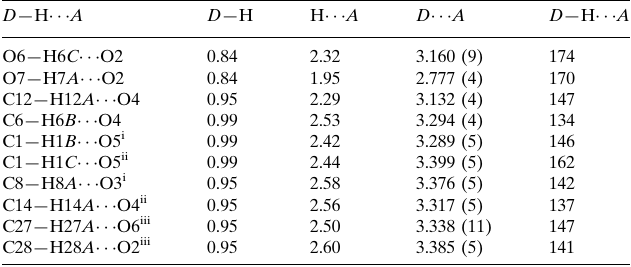
Hydrogen-bond geometry (A˚ , (cid:2)